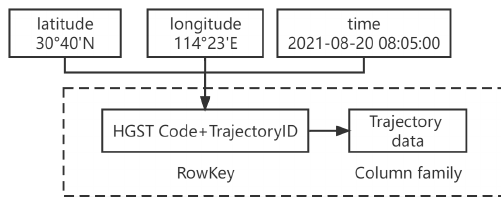
Figure 7. The diagram of key-value store